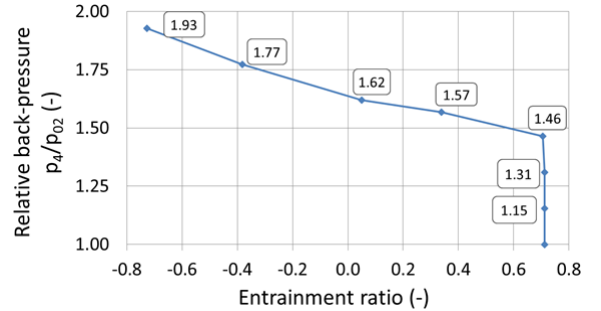
Fig. 6. Performance line of the ejector.